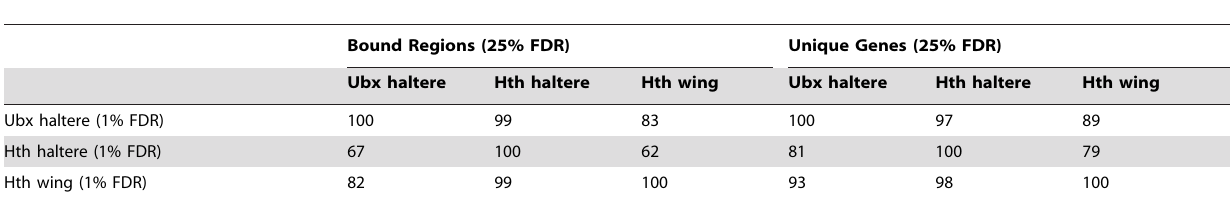
Table 2. Percentage overlap between ChIP profiles in terms of bound regions and unique genes when peaks at 1% FDR are compared with 25% FDR